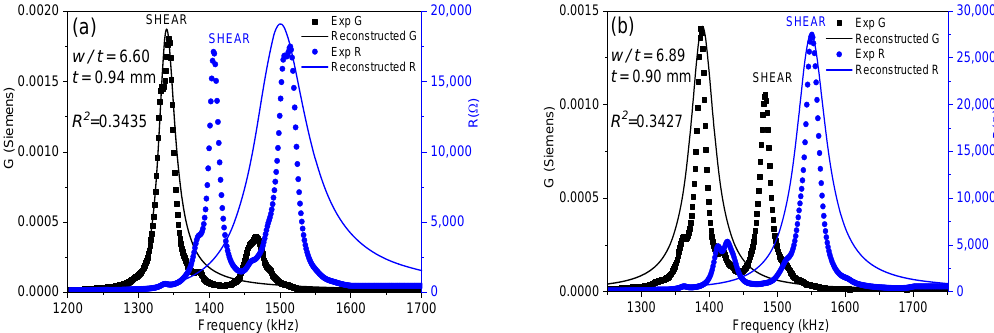
Figure 5. Impedance spectra showing coupled modes (very low R 2 ) for the BCZT plate for aspect ratios ( a ) w / t = 6.60; ( b ) w / t = 6.89. Experimental G and R peaks (symbols) are displayed, as well as reconstructed peaks (solid lines).